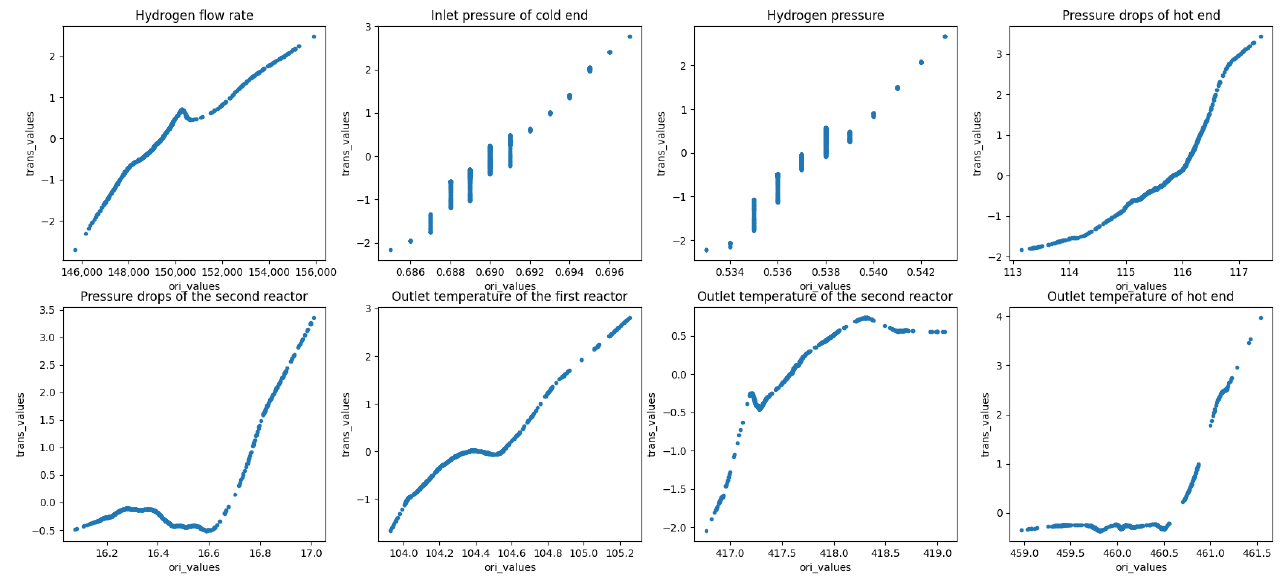
Figure 13. Ace transformation relation of the selected variables.